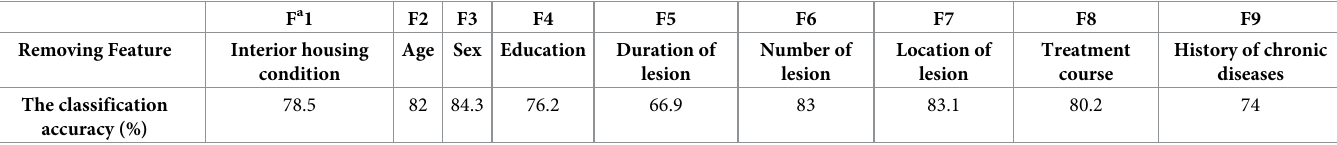
Table 3. Removing features in order to determine the effectiveness of each